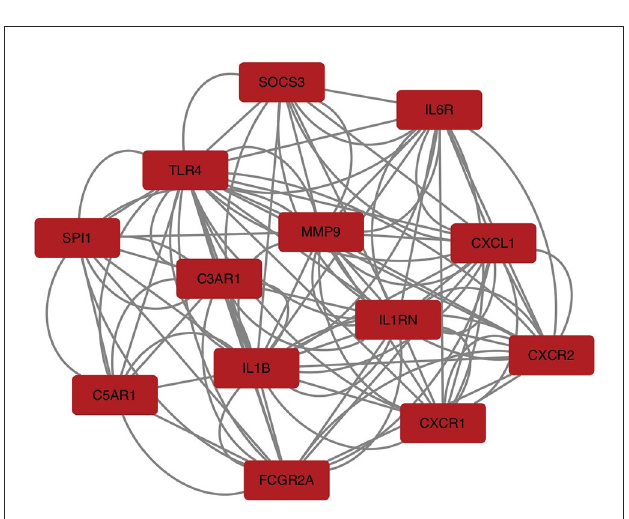
FIGURE9 PPI network of hub module genes related to the infiltration of immune cells. The closer the relationship, the higher the number of adjacent nodes of genes. PPI, protein–protein interaction.